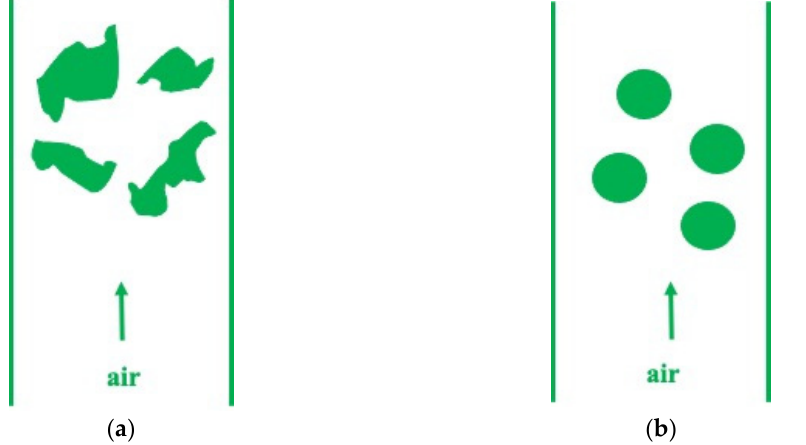
Figure 13. Concept of acuteness by Permaran technique: ( a ) more acute particles; ( b ) less acute particles (modified from [128]).